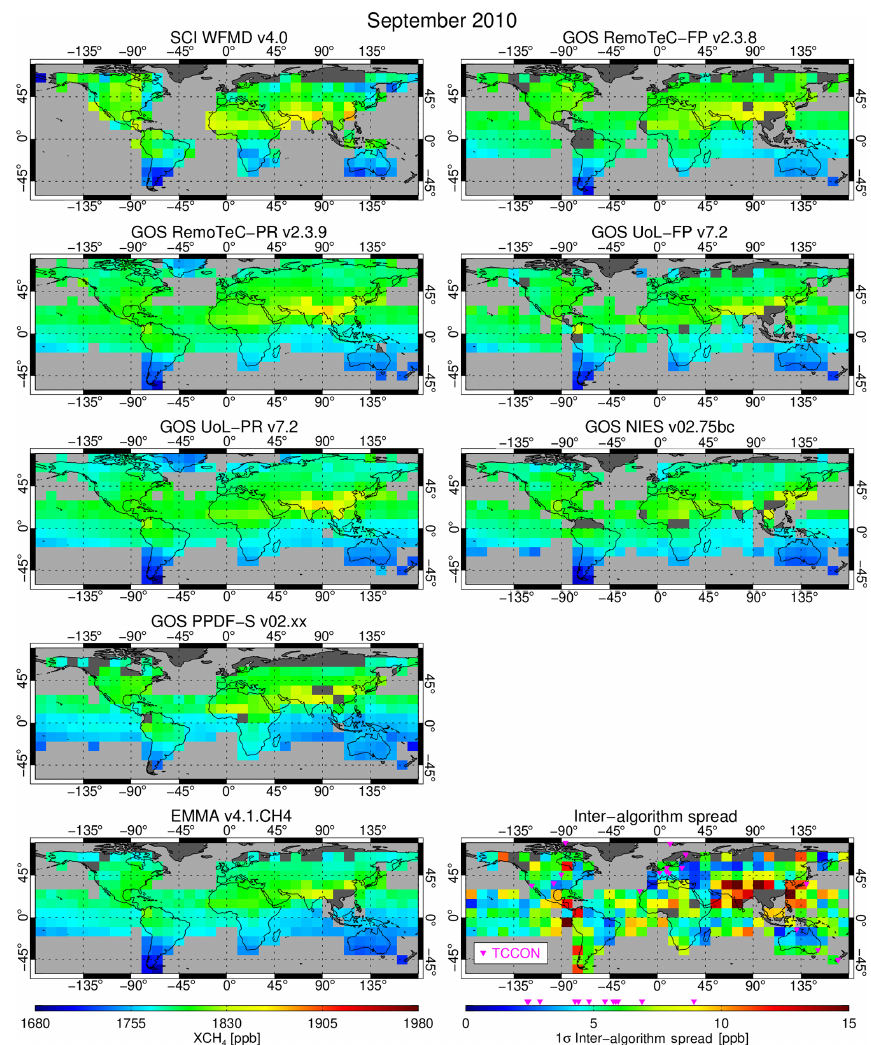
Figure 14. September 2010 XCH 4 at 10 ◦ × 10 ◦ spatial resolution showing (i) the individual sensor/algorithm input data sets (panels in rows 1–4; see Table 2 for details), (ii) EMMA XCH 4 (bottom left), and (iii) the inter-algorithm spread (IAS, 1 σ ) as computed by EMMA (bottom right; see main text for details). Also shown in the bottom-right panel are the locations of the TCCON sites (pink triangles) and the range of IAS values covered by them (see color